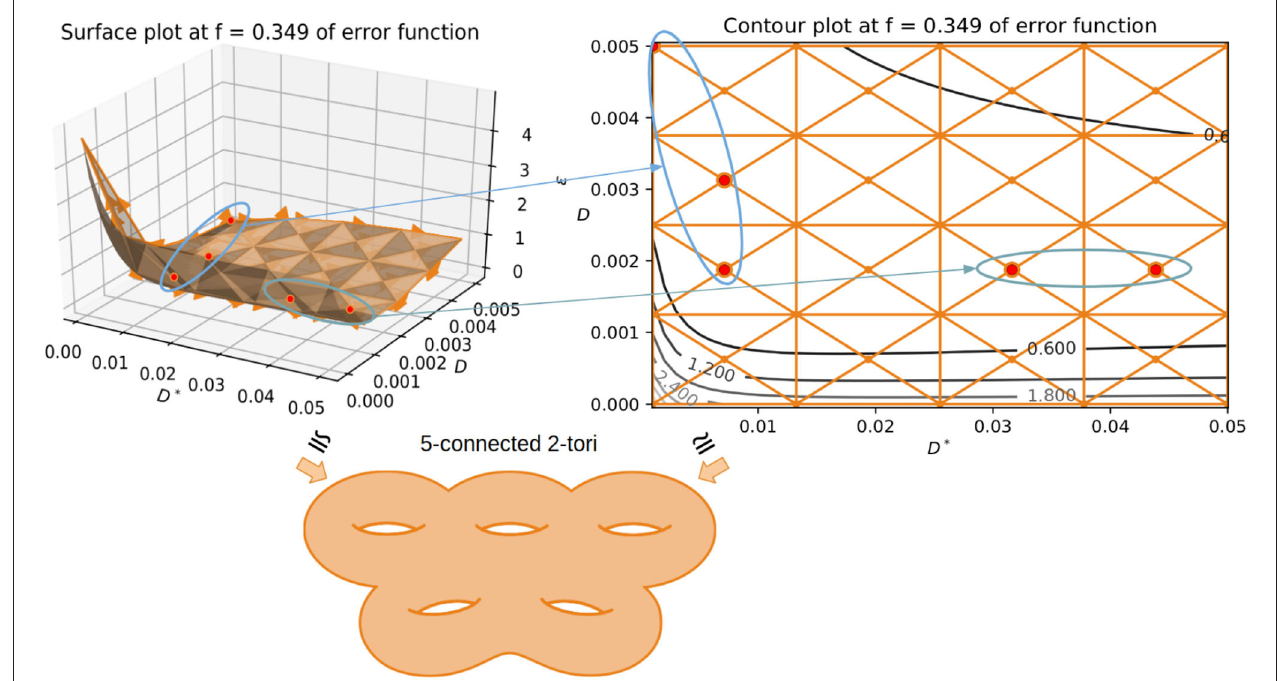
FIGURE 4 | Showing the use of simplicial homology groups to visualize the two biophysically feasible global minima via a surface plot and contour plot. The chain-complex associated with both the minima is highlighted in each case with arrows showing correspondences. Both sub-domains contain a valley of infinite physically plausible solutions for the IVIM problem, one high perfusion and one low perfusion sub-domain. The minima of the depicted objective function surface and its corresponding contour plot is homologous to 5 connected